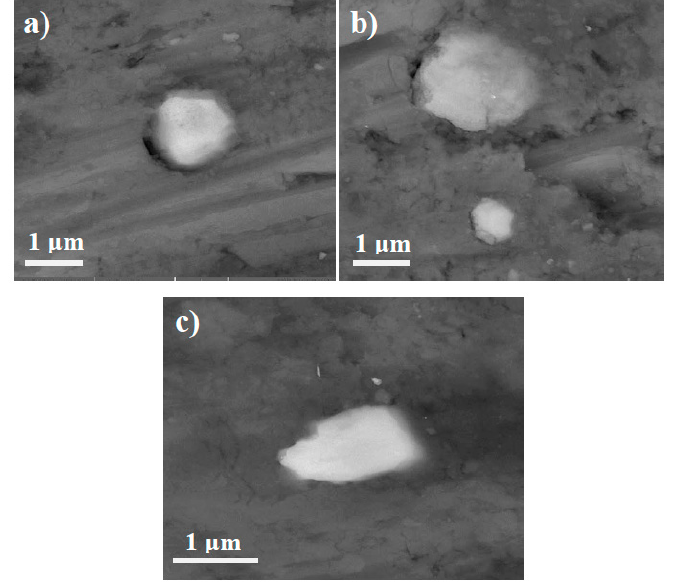
Figure 6. FESEM micrographs of: ( a ) conventional; ( b ) microwave; and ( c ) SPS sintered samples.